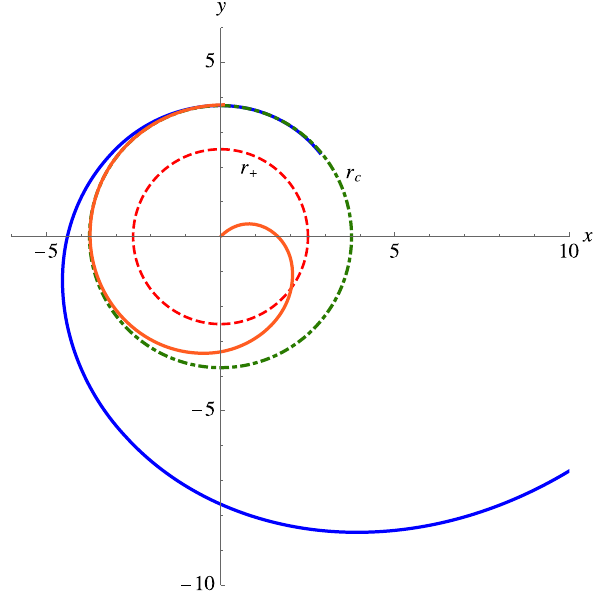
Fig. 8 TheCOFK(blue)andtheCOSK(orange),plottedinaccordance with the information given in Fig.